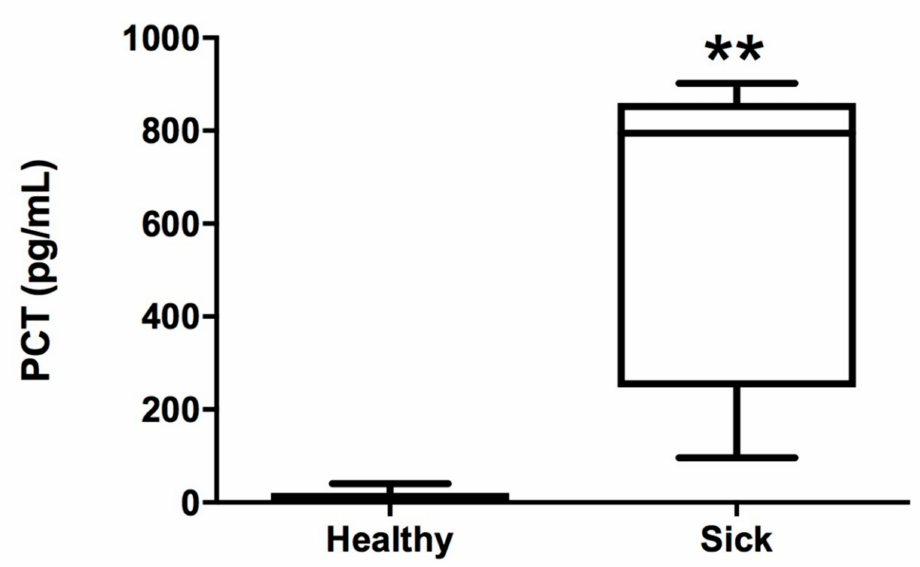
Figure 1. Concentrations of PCT measured by the rcPCT kit in healthy and sick canine plasma samples (** p < 0.01).